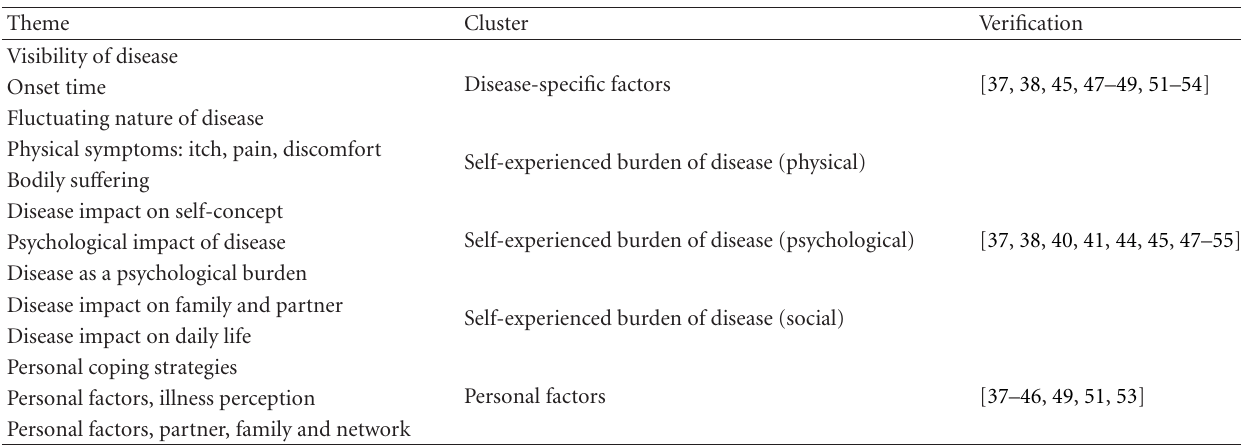
Table 3: Themes, clusters and verification of